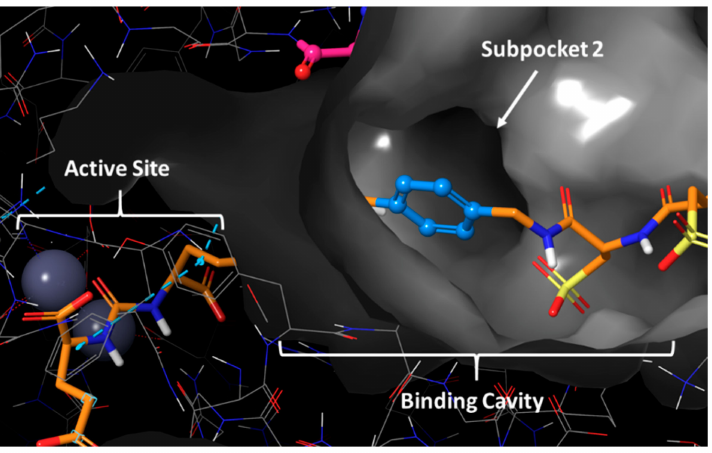
Figure 4. Crystal structure of PSMA and the co-crystallized ligand PSMA-1027 depicted in orange. PDB code 5O5U.